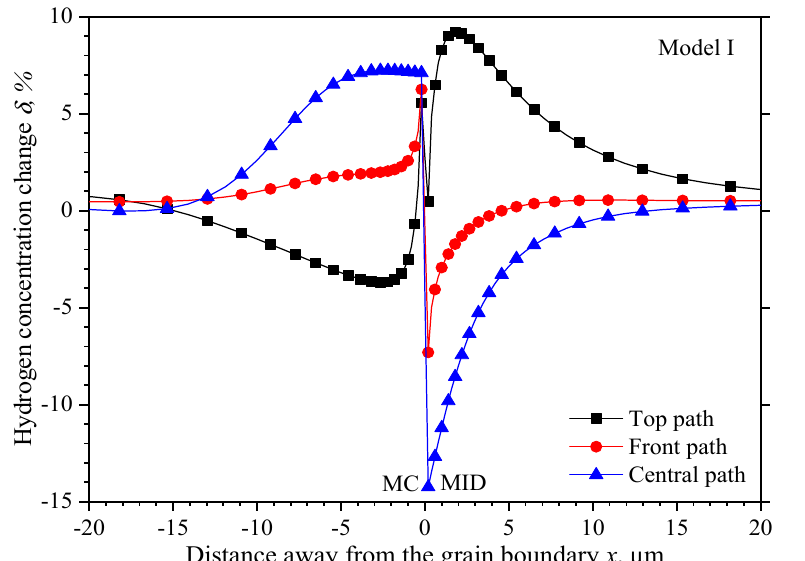
Figure 5. Observation paths.